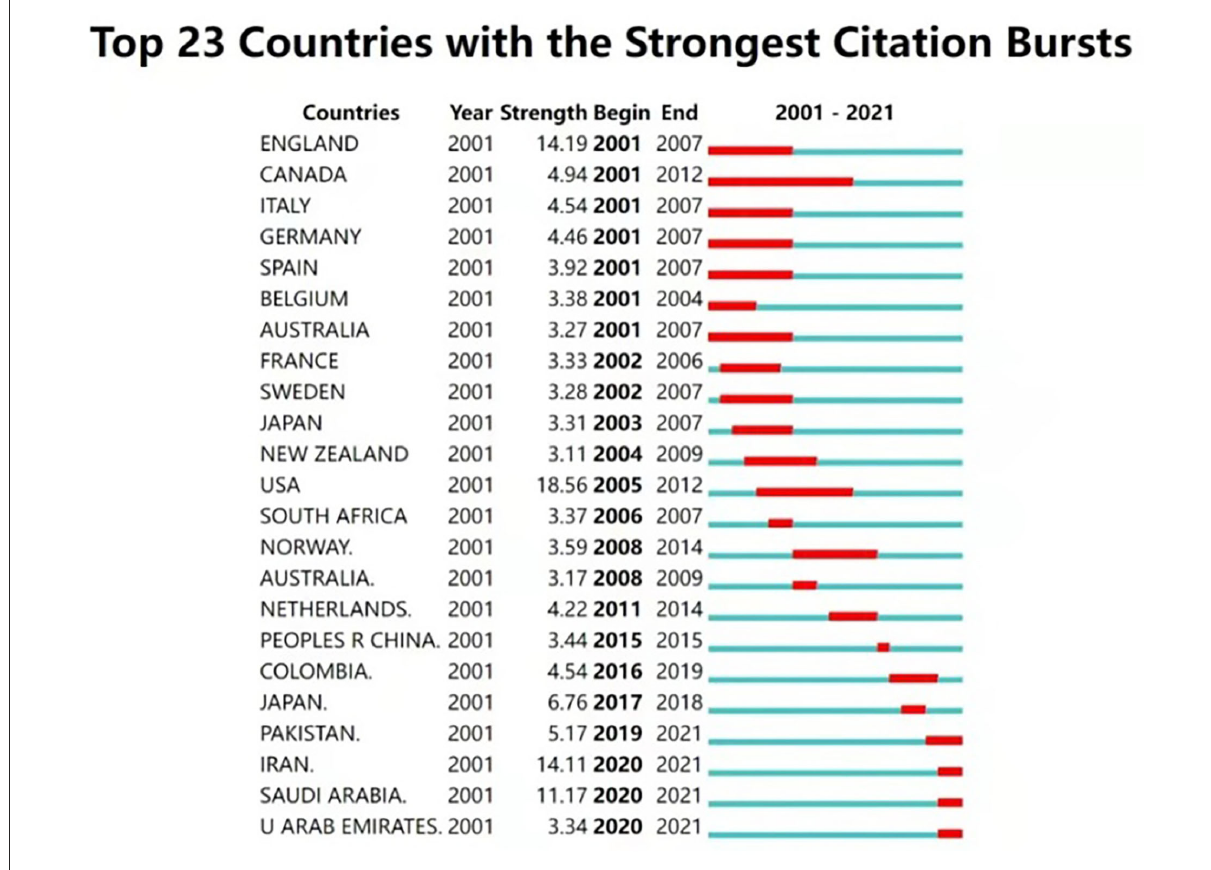
FIGURE3 Top 23 countries with the strongest citation bursts (2001–2021). The blue line represents the period, and the red line represents the duration of the citation burst.